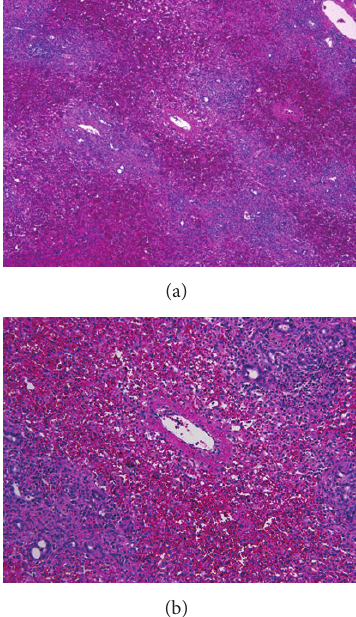
Figure 2: The recipient’s explanted liver showed no cirrhosis, and thehepaticarchitecturewaspreserved(hematoxylinandeosin;orig- inal magnification 40x) (a). Massive hemorrhagic hepatic necrosis was also seen (hematoxylin and eosin; original magnification 200x)